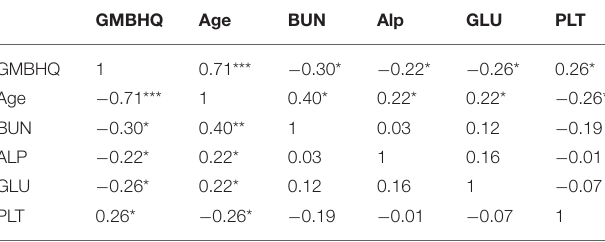
TABLE 3 | Correlations between the GM-BHQ, subject age and the blood data.